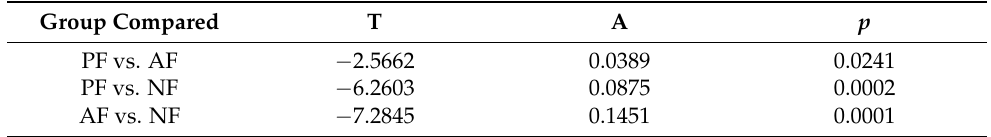
Table 3. Multi-response permutation procedures (MRPP) to test for significance of variation in natural forest (NF), abandoned fallows (AF) and planted forest (PF). Group Compared T A